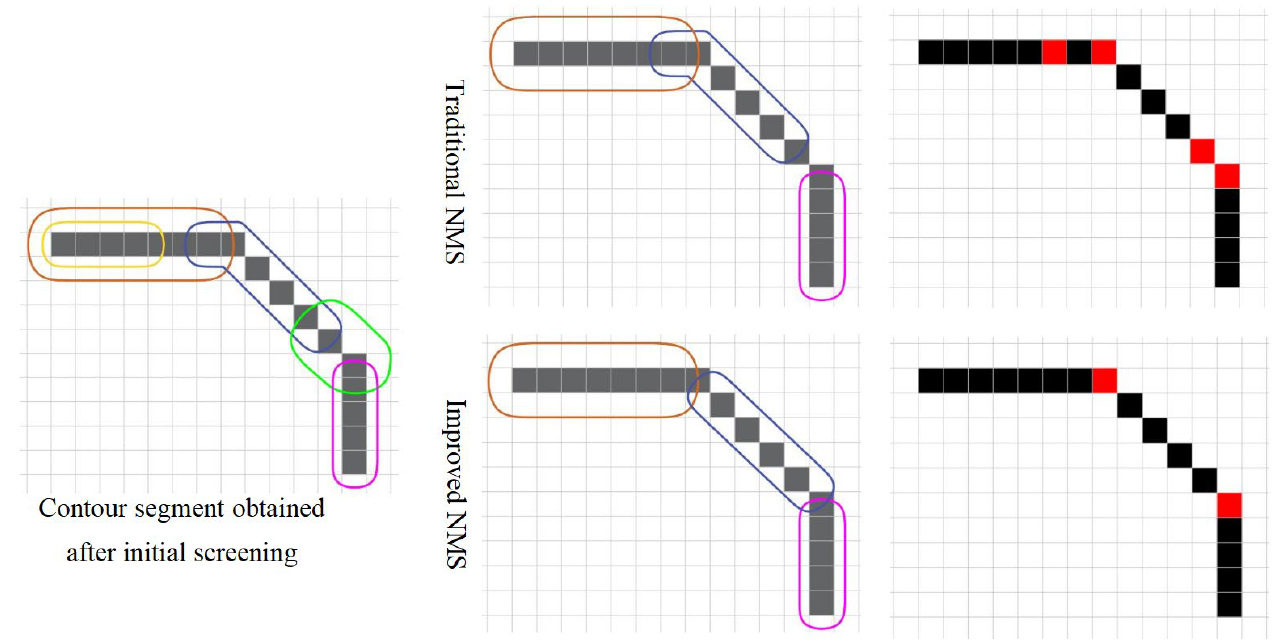
Figure 19. Schematic of the effect of the improved NMS algorithm. The workflow of the improved NMS algorithm is shown in Figure 20.